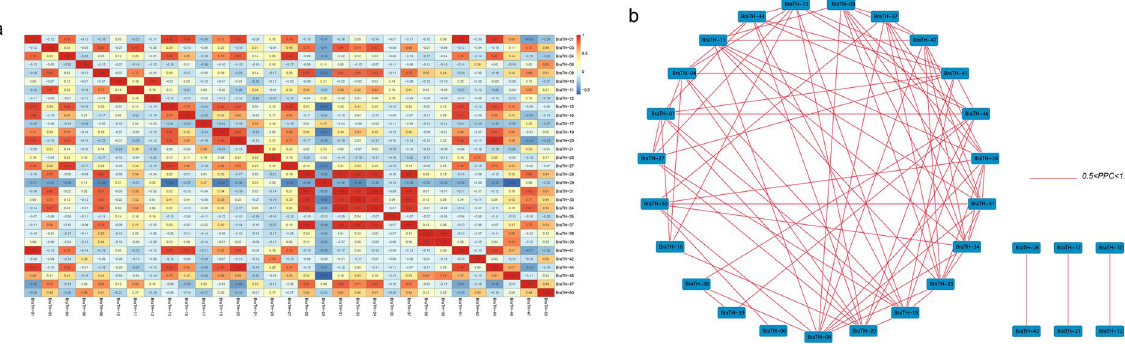
Figure 8. Correlations and co-regulatory networks of 31 trihelix genes under stress treatments. ( a ) Correlation analysis by using the R package program. Each correlation is shown by the shades of blue and orange. Blue and orange indicate a positive correlation and negative correlation, respectively. ( b ) Co-regulatory networks. The co-regulatory networks of 31 trihelix genes under stress treatments were established based on the Pearson correlation coefficients (PCC) of these gene pairs using transformed qPCR data The PCC of co-regulatory gene pairs was considered significant at the 0.05 significance level (p-value), and different colour line styles indicate the different significance levels of the co-regulated gene